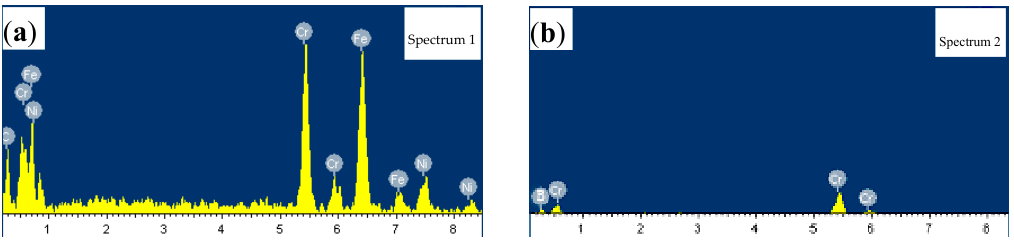
Figure 2. Energy-dispersive Spectroscopy ( EDS) results of ( a ) spectrum 1 and ( b ) spectrum 2. Elemental distribution across the brazed region of 1Cr18Ni9Ti steel with BNi-2 filler metal was 3.2. Microstructure of the Brazed Joint with BNi82CrSiBFe Filler